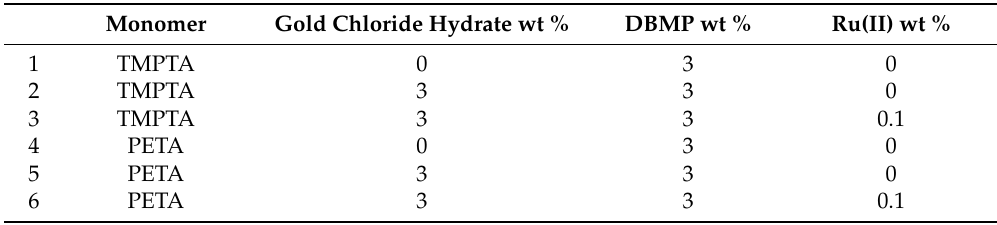
Table 1. Composition of 6 formulations, based on trimethylopropane triacrylate (TMPTA) and pentaerythritol triacrylate (PETA) monomer